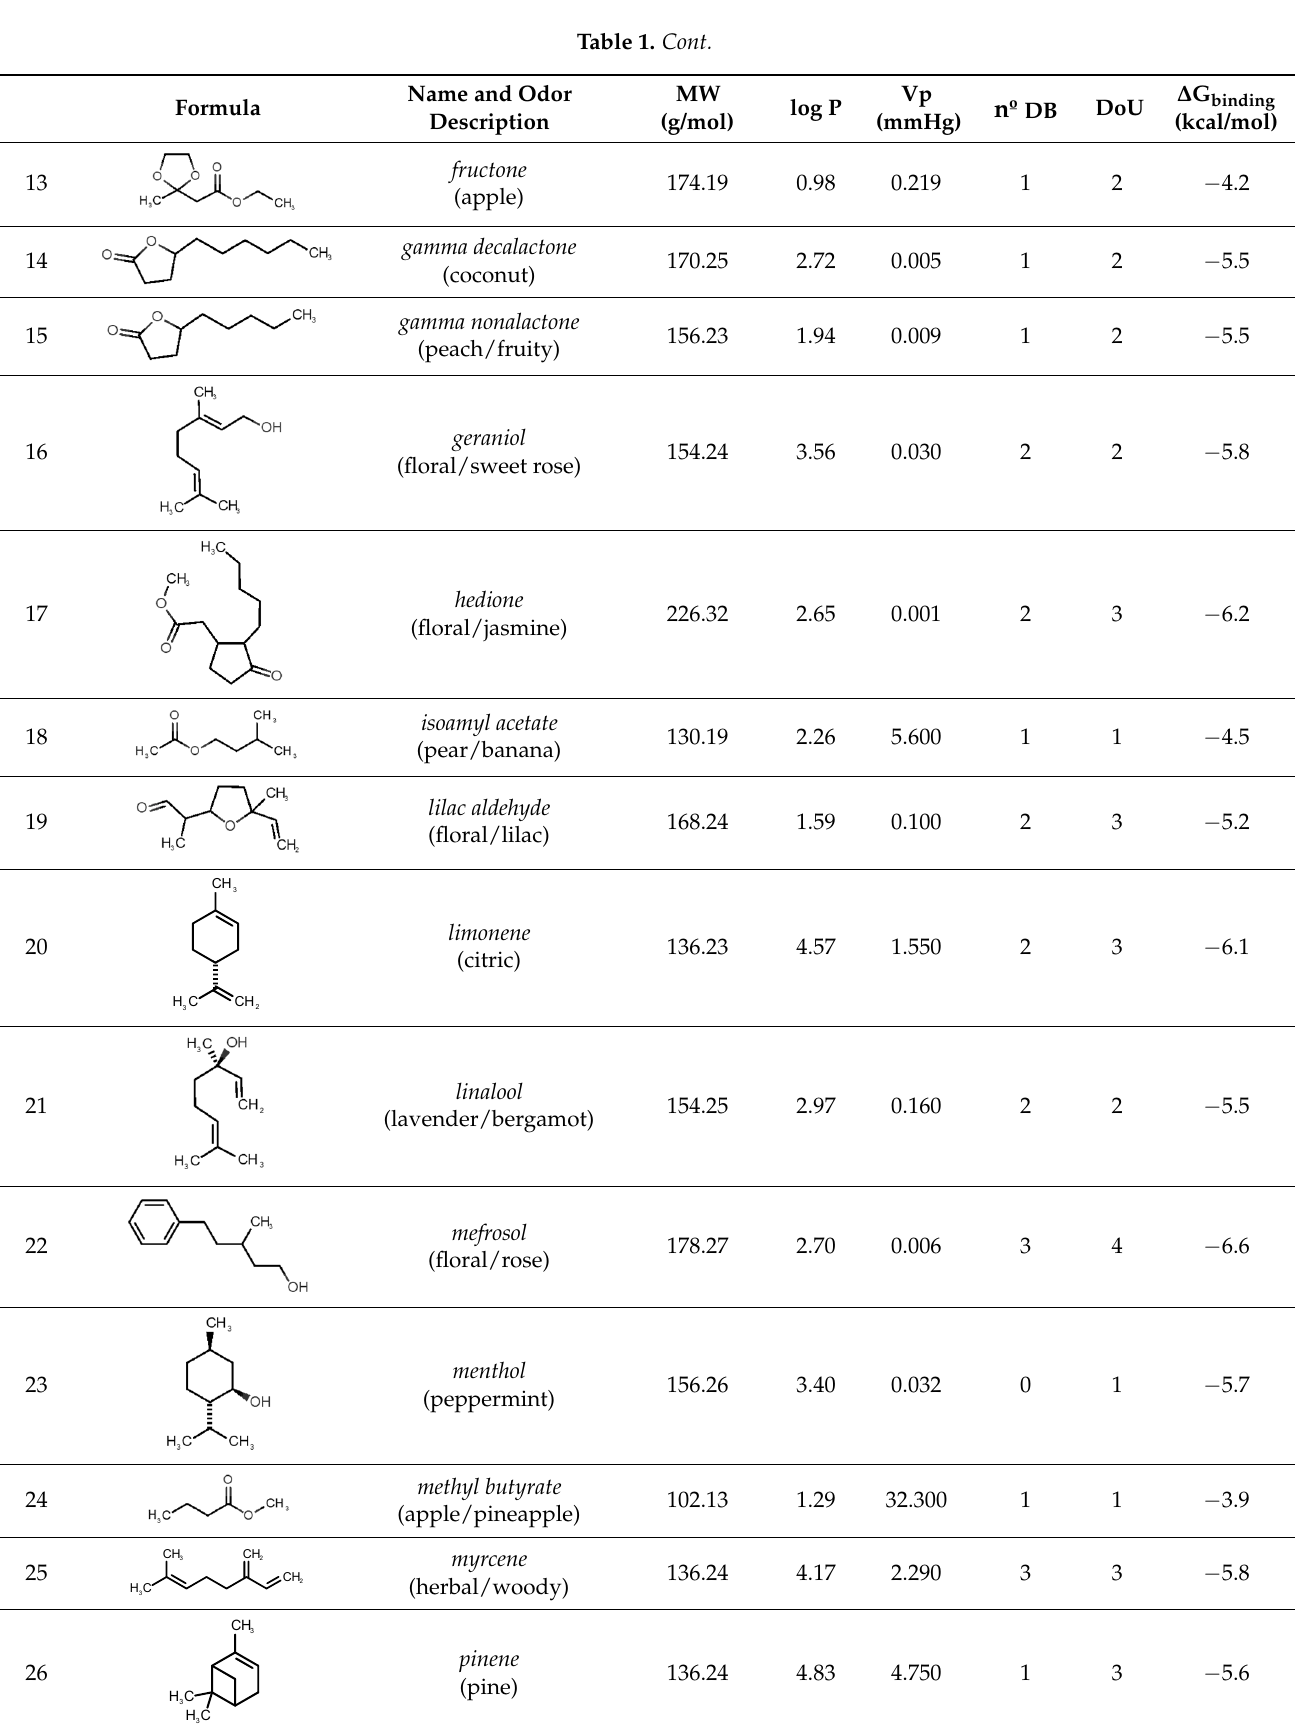
Table 2. Description of unpleasant odorant molecules under study, according to physicochemical and structural charac-